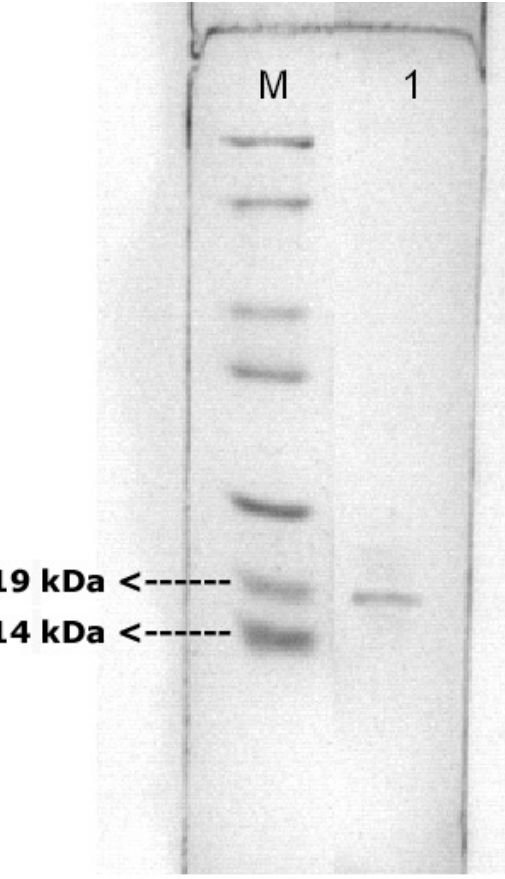
Figure 4. SDS-PAGE analysis of purified fractions. M: standard protein molecular weight marker (Bangalore Genei, India). Lane 1: pooled active fractions from gel filtration